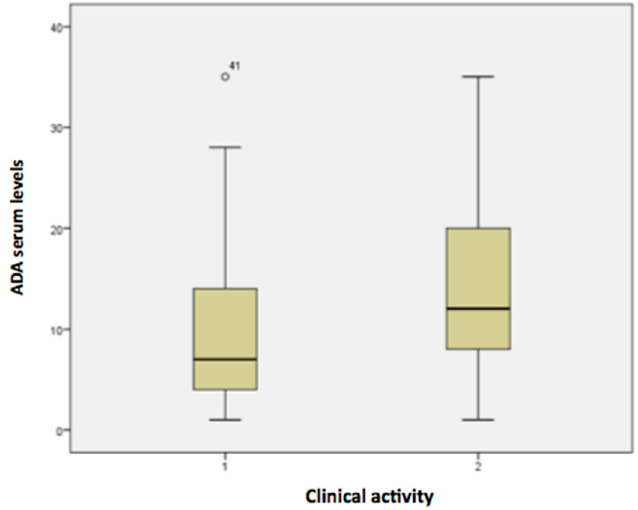
Figure 1. Boxplot demonstrating median serum ada concentrations and clinical disease activity in cd (1: active disease; 2: clinical remission).